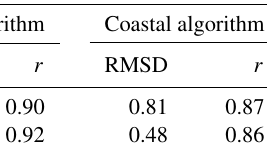
Table 1. RMSD (mgm − 3 ) and correlation ( r ) between Chl a